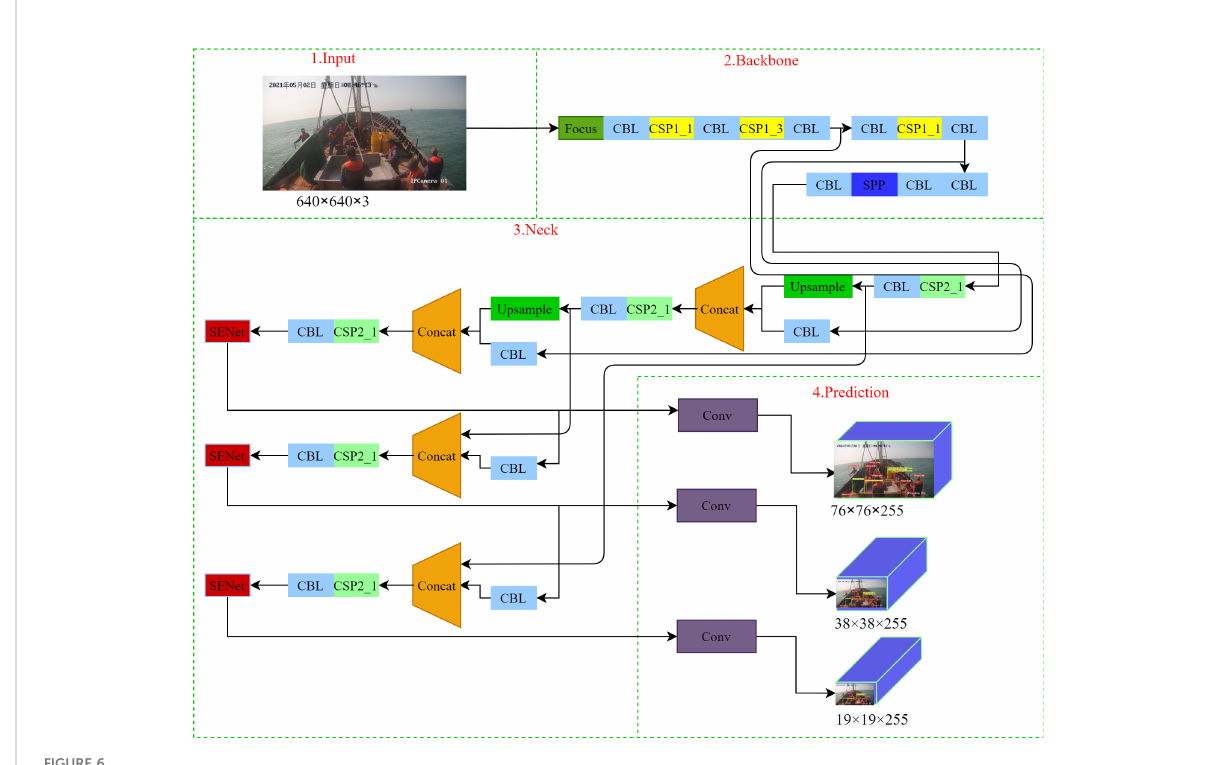
FIGURE 6 YOLOv5 fusion attention mechanism